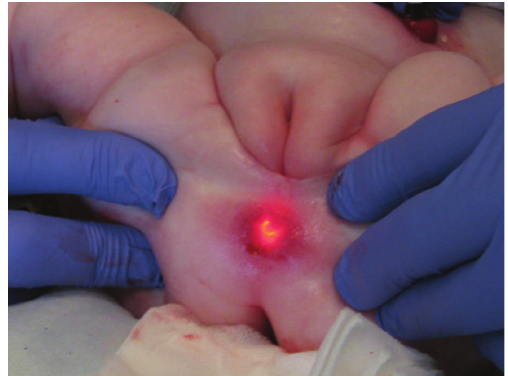
Figure 8: The anastomosis was completed with another 6 stitches of a monofile suture. Then a Foley catheter was placed for 7 days in order to avoid an immediate stricture.